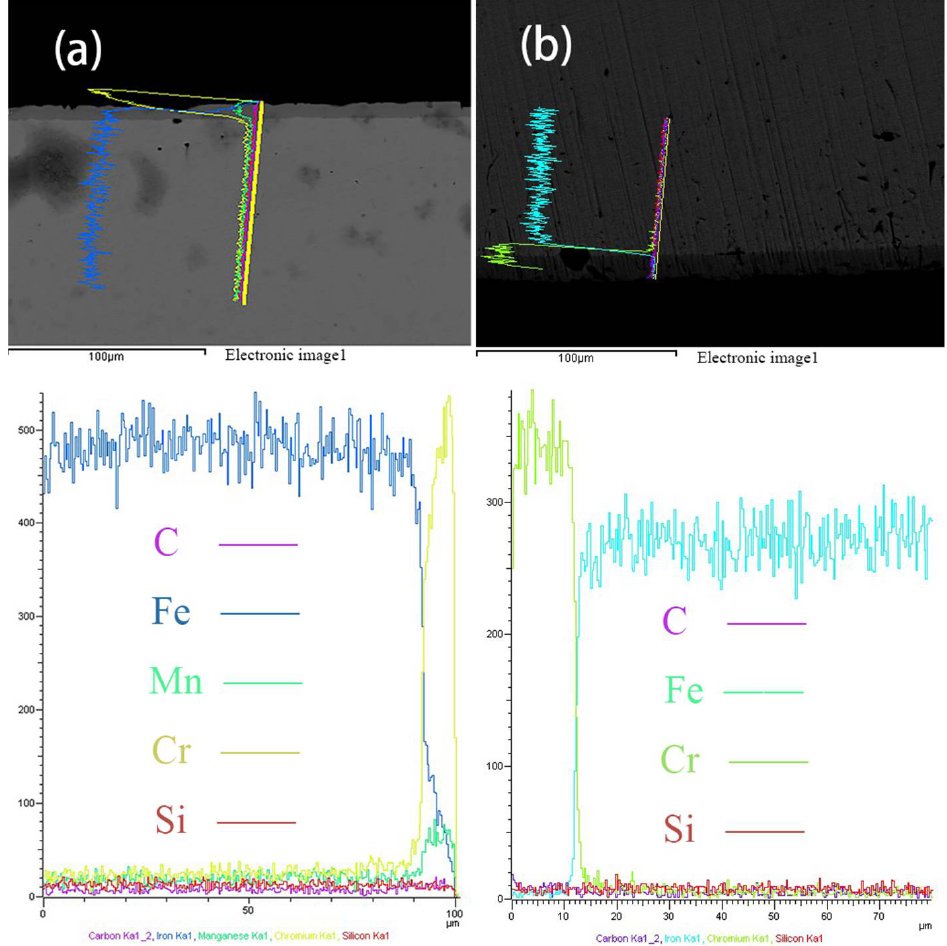
Figure 5. Section line scanning of two specimens. ( a ) Chromium carbide coating. ( b ) Chromium plating coating.